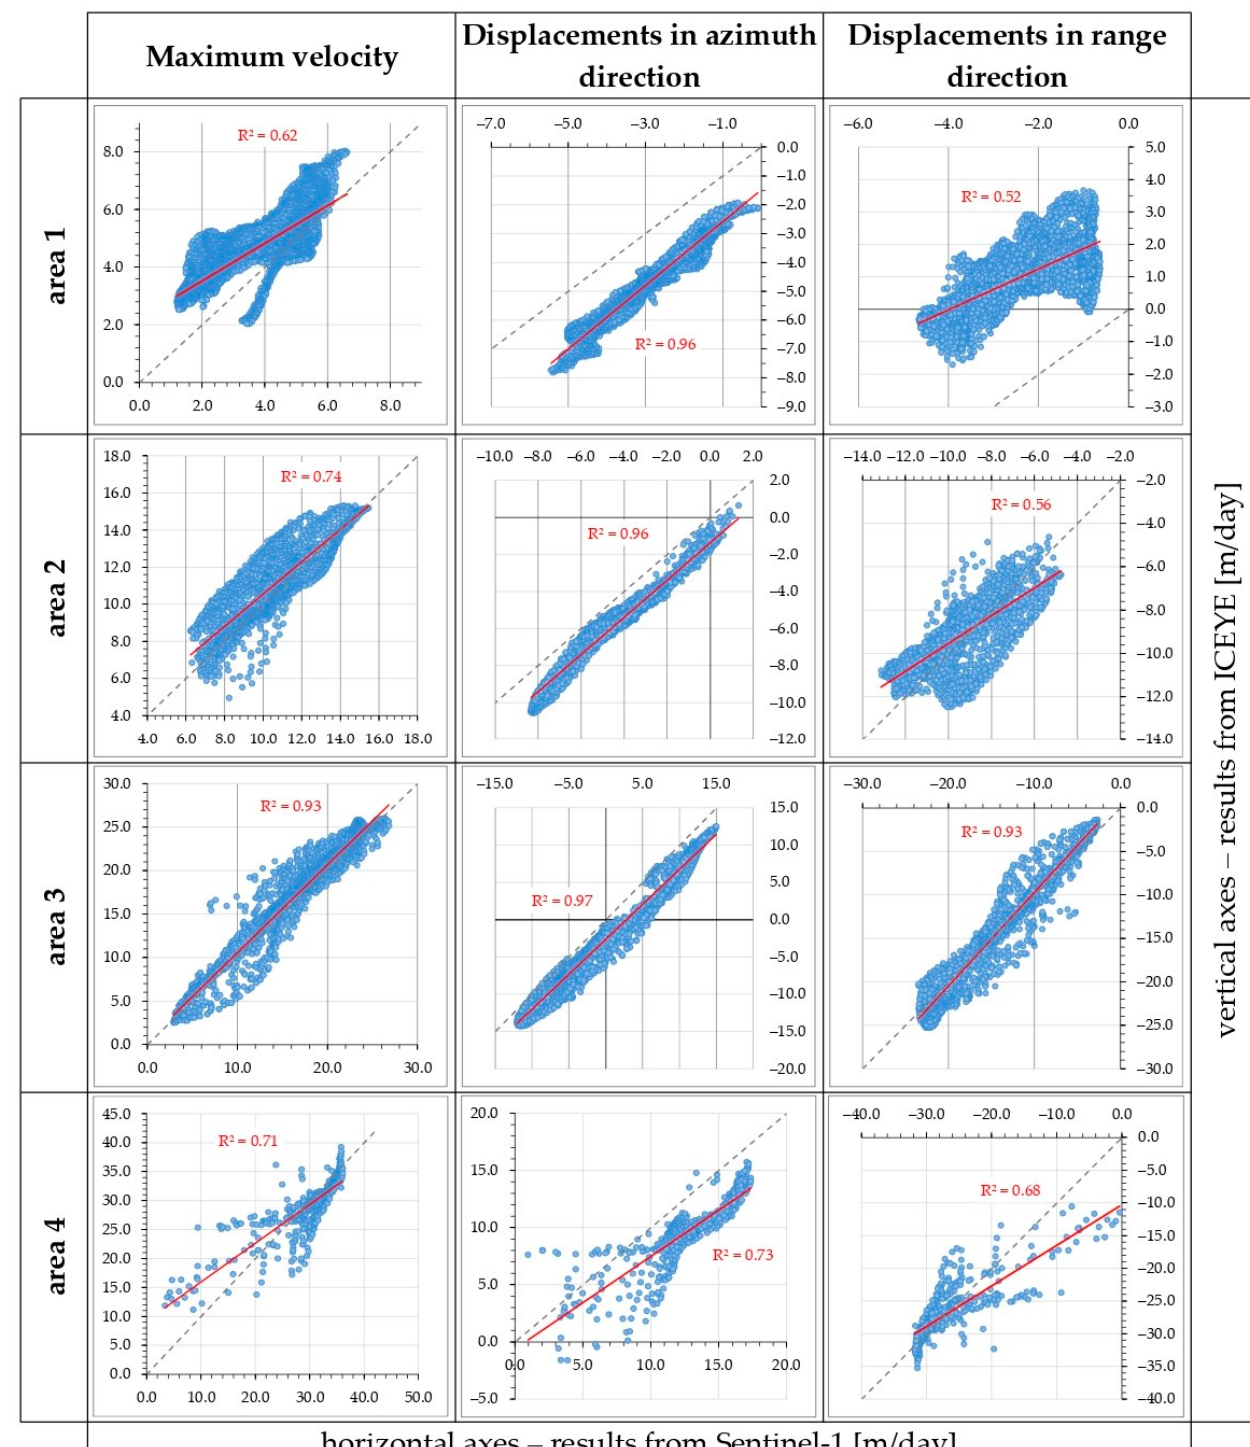
Figure 5. Correlation plots for selected parts of the glacier for the area in the interior of the glacier ( area 1 ), in area of higher velocities ( area 2 ), in area of high-intensity movements ( area 3 ), in the area of maximum values near the terminus ( area 4 ).